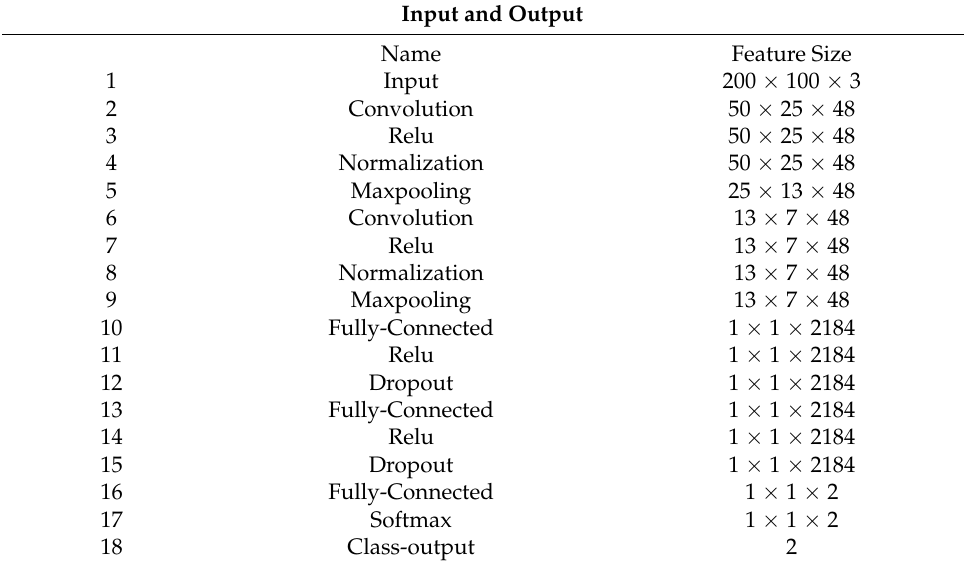
Table 2. Input and output of each layer for the proposed CNN model. Input and Output Name Feature